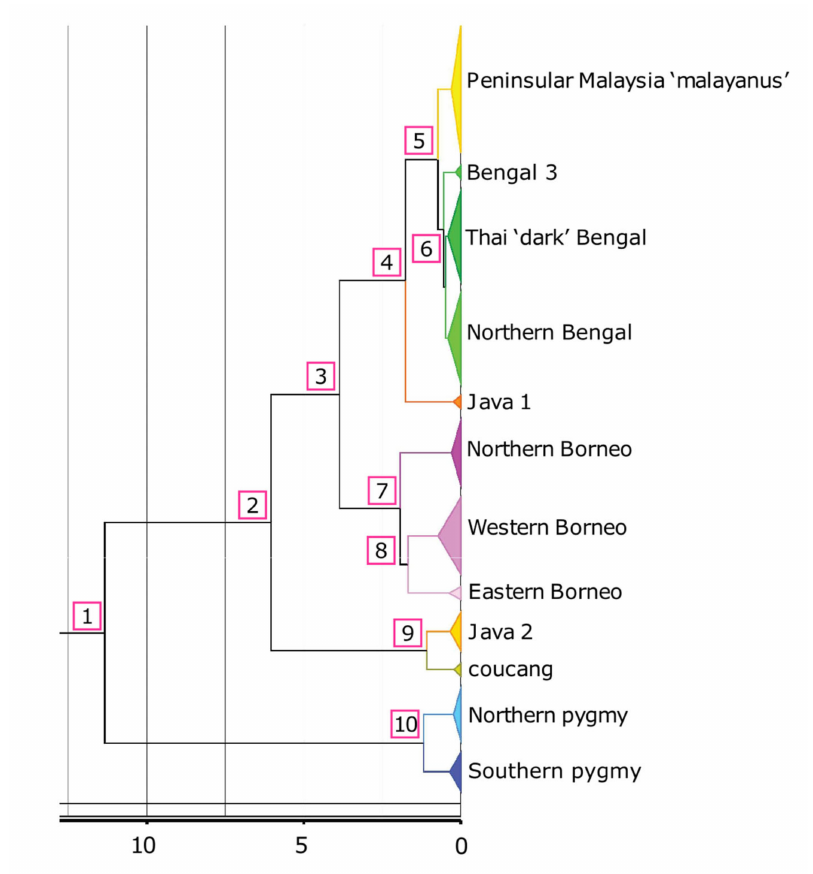
Figure 3. Estimated divergence ages of clades corresponding to those shown in Figure 2. Specific estimates with 95% highest probability densities (HPDs) are provided in Table 3. A time scale is given below the tree (values are millions of years